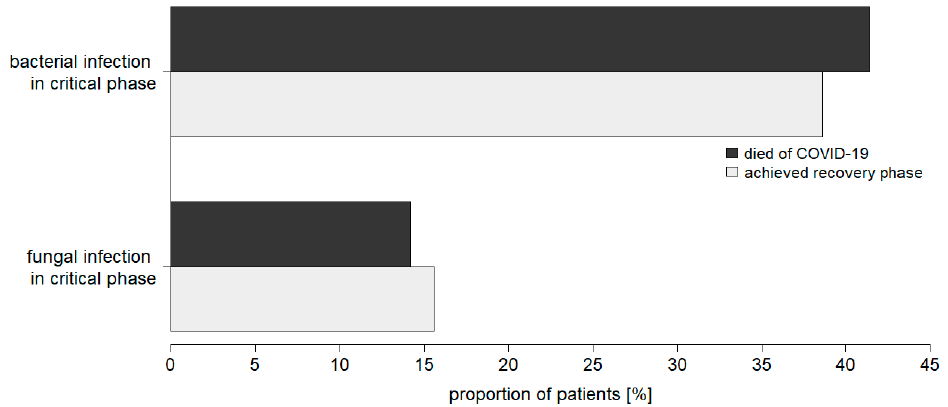
Figure 4. Prevalence of secondary bacterial and fungal infections in recovered and deceased patients critically ill with COVID-19 (total cohort).